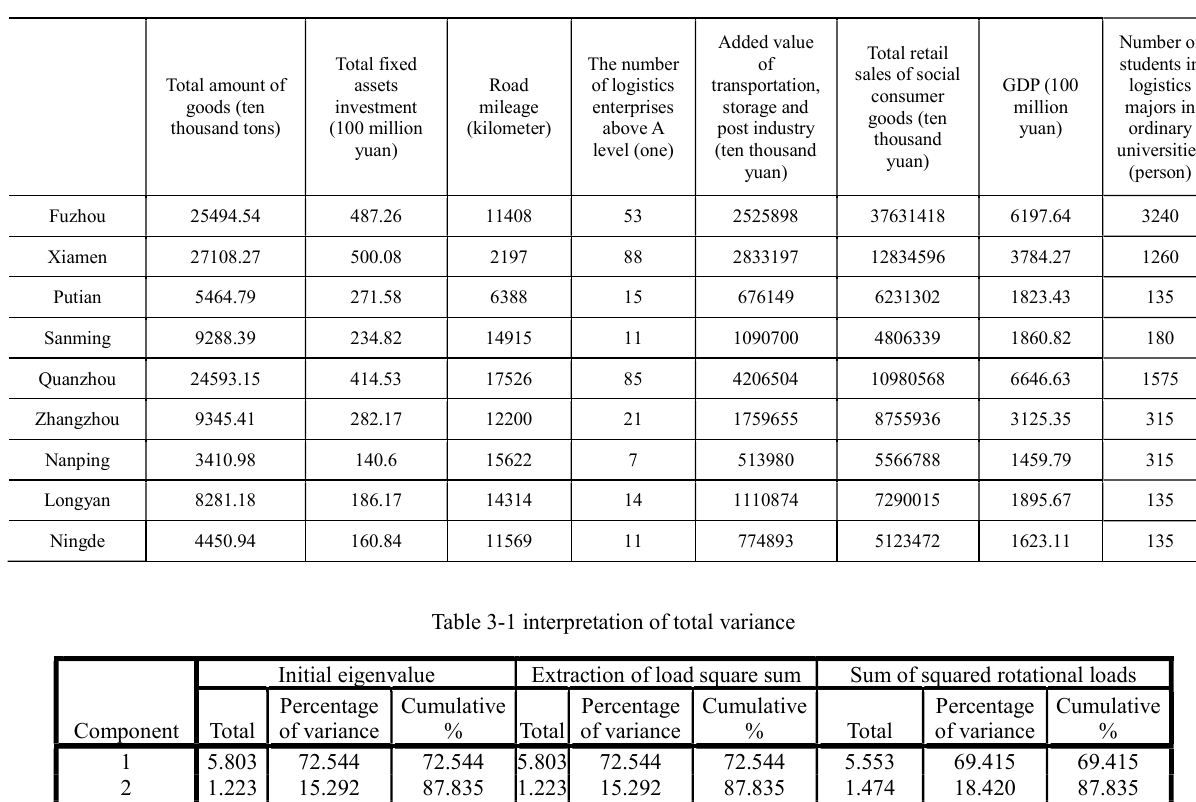
Table 2 Index data of 9 cities in Fujian Province in 2016